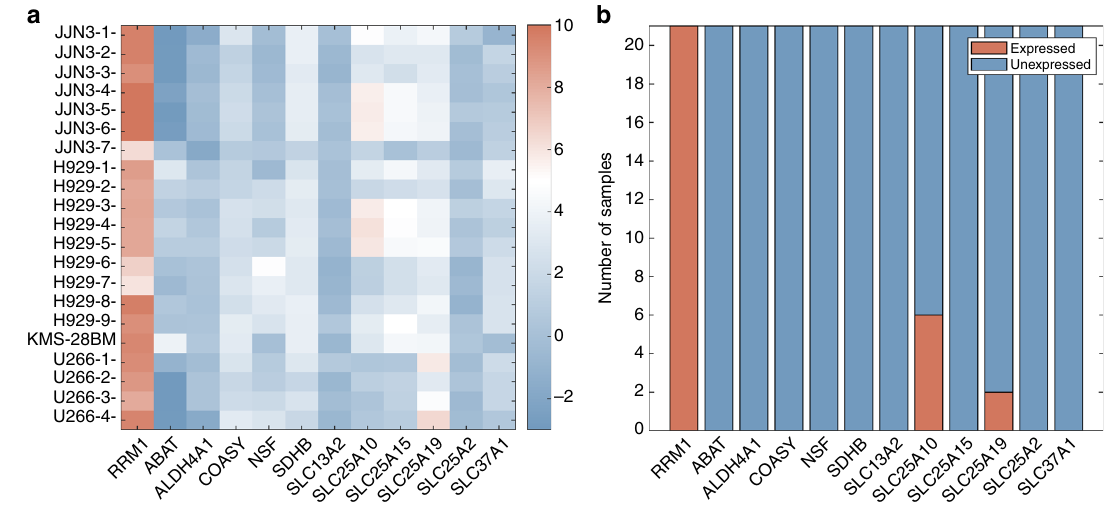
Fig. 2 Expression levels of genes included in gMCS 6 for different samples of the MM cell lines considered. a Heatmap of Barcode z -scores 23 of RRM1 and its partner genes (gMCS 6 ) in different MM samples analyzed. b Number of MM samples where RRM1 and its partner genes (gMCS 6 ) are expressed/ unexpressed, according to Barcode threshold of expression ( z ≥ relationships (GPR rules) (Fig. 1b), we fi nd a gMCS (gMCS 2 )